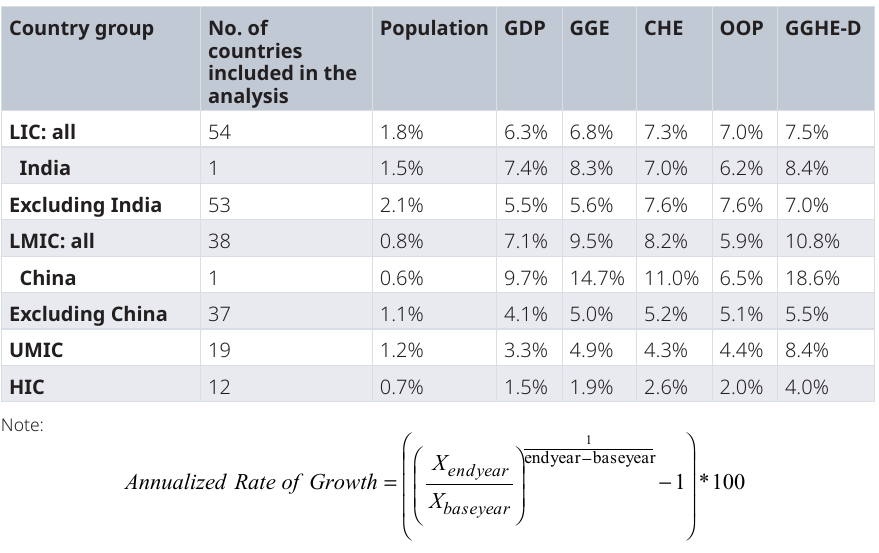
Table 3. Annual rate of growth, key indicators, 2000 to